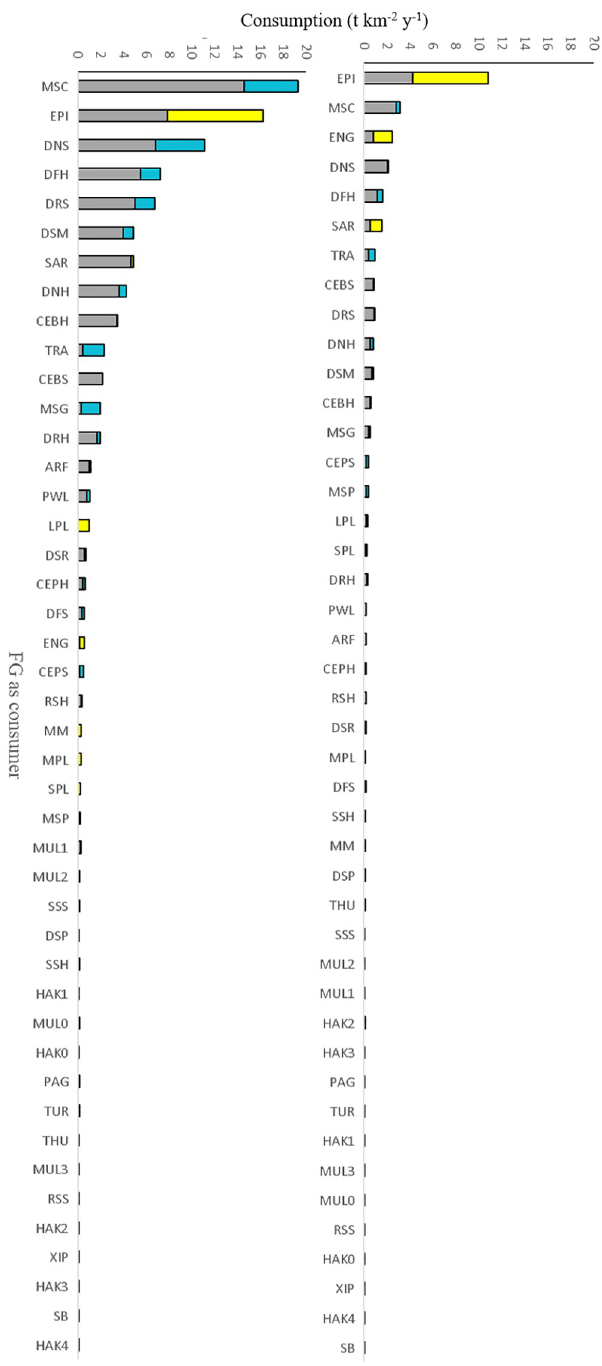
Fig 4. BPC by flux (consumption) of functional groups (FG) acting as consumers (left) and as sources (right) on the 2 other domains they do not belong to. Pelagic (cyan), demersal (yellow), benthic (gray), lower trophic level groups are